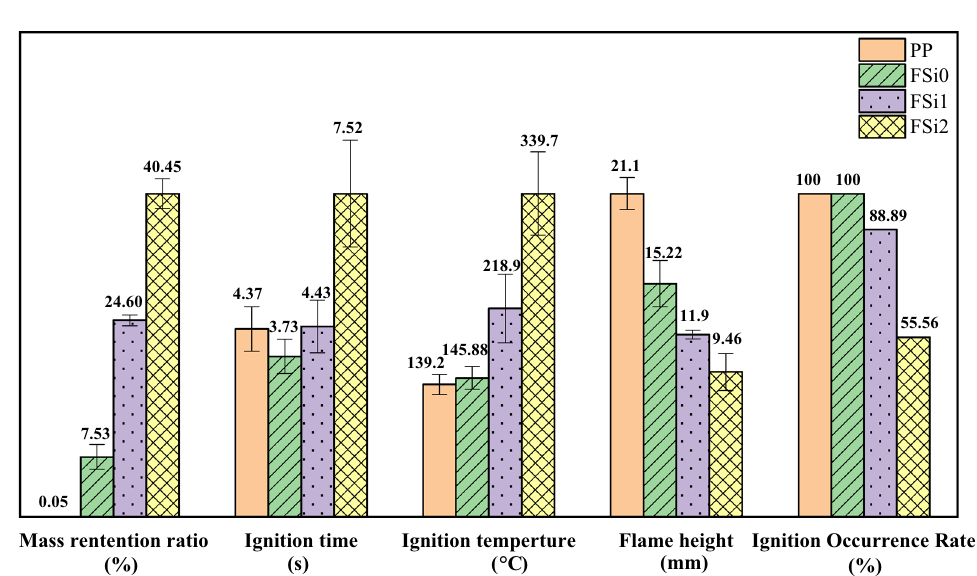
Figure 11. The heating ignition test results for fungal fibers grown with different concentrations of Si